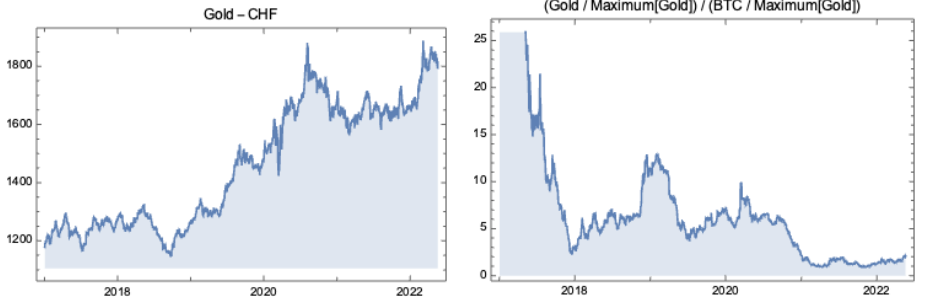
Figure 2. Price of Gold from 2017 to the present (left) and ratio of normalised prices of Gold and Bitcoin